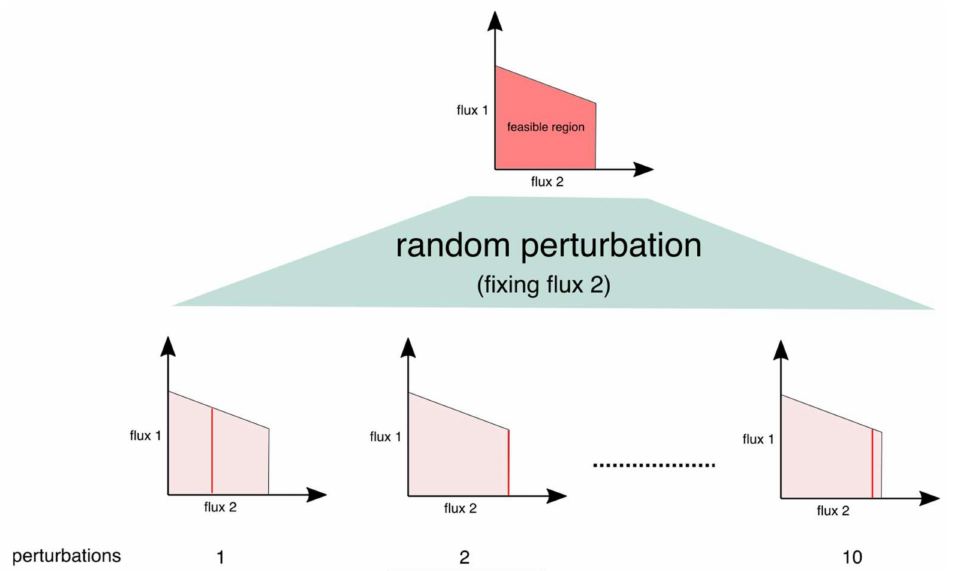
Figure 10. Perturbation procedure to determine the robustness of FBA/FVA outcome. The fig- ure shows how fixing one reaction at various random values results in a different range for flux combinations between two fluxes.